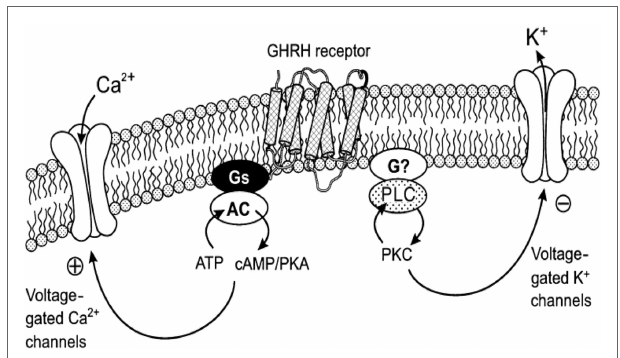
FiGURe 1 | Mechanism of the action of GHRH on Ca 2 + and K + channels: coupling with protein kinase A (PKA) and protein kinase C (PKC) systems . This diagram illustrates the coupling of the Ca 2 + and K + channels with GHRH receptors. cAMP–PKA system mediates the action of GHRH on voltage-gated Ca 2 + currents, and the PKC system is essential for the action of GHRH on voltage-gated K + currents in somatotropes. AC, adenylyl cyclase; PLC, phospholipase C. Reprinted by permission from Macmillian Publishers Ltd., from Ref (23), Figure 11.